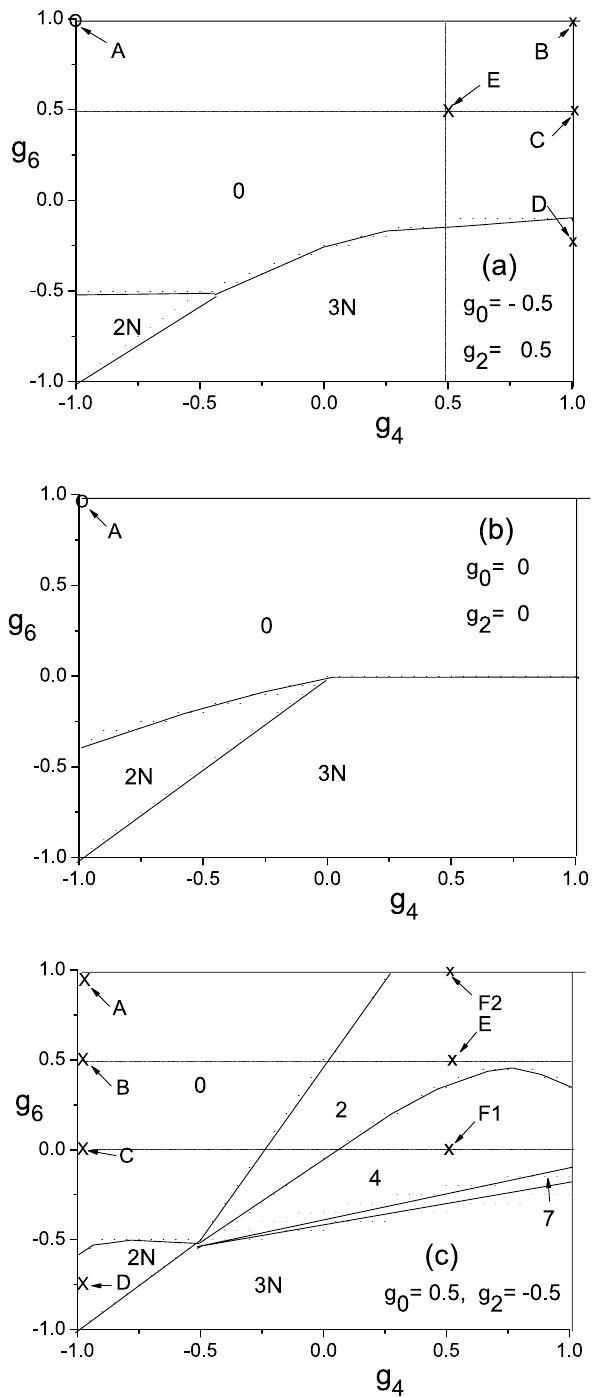
Figure 1. Phase diagrams of the g.s. of N = 4 systems against g 4 and g 6 , while g 0 and g 2 are fixed and marked in the panels. S is marked on the associated